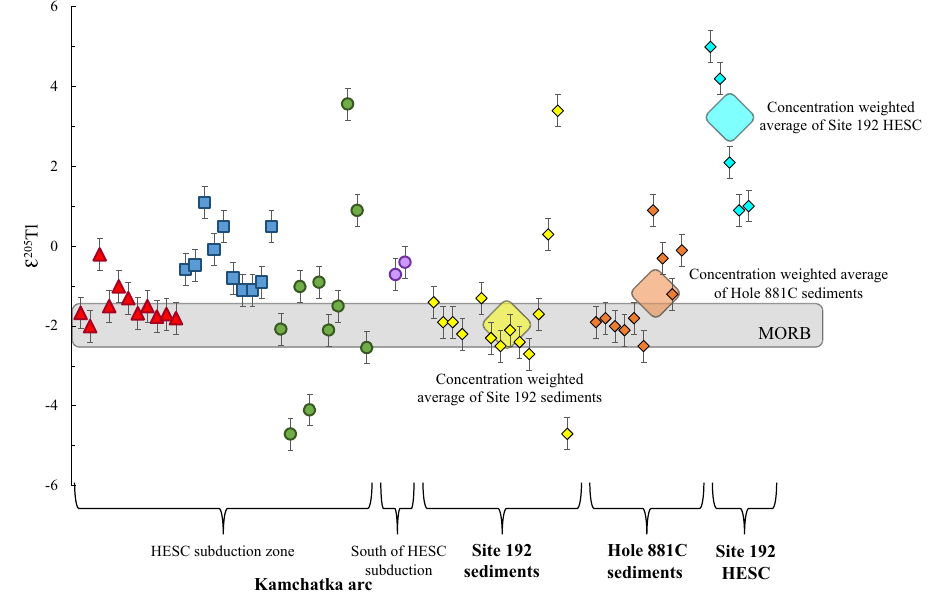
Fig. 4 | Thallium isotope compositions of Kamchatka lavas that have been fi ltered for degassing and deep ocean-island-basalt (OIB) components (see discussionfordetails),sedimentsandHawaii-EmperorSeamountChain(HESC) basalts from the two drill cores. Grey area in chart denotes the Tl isotope